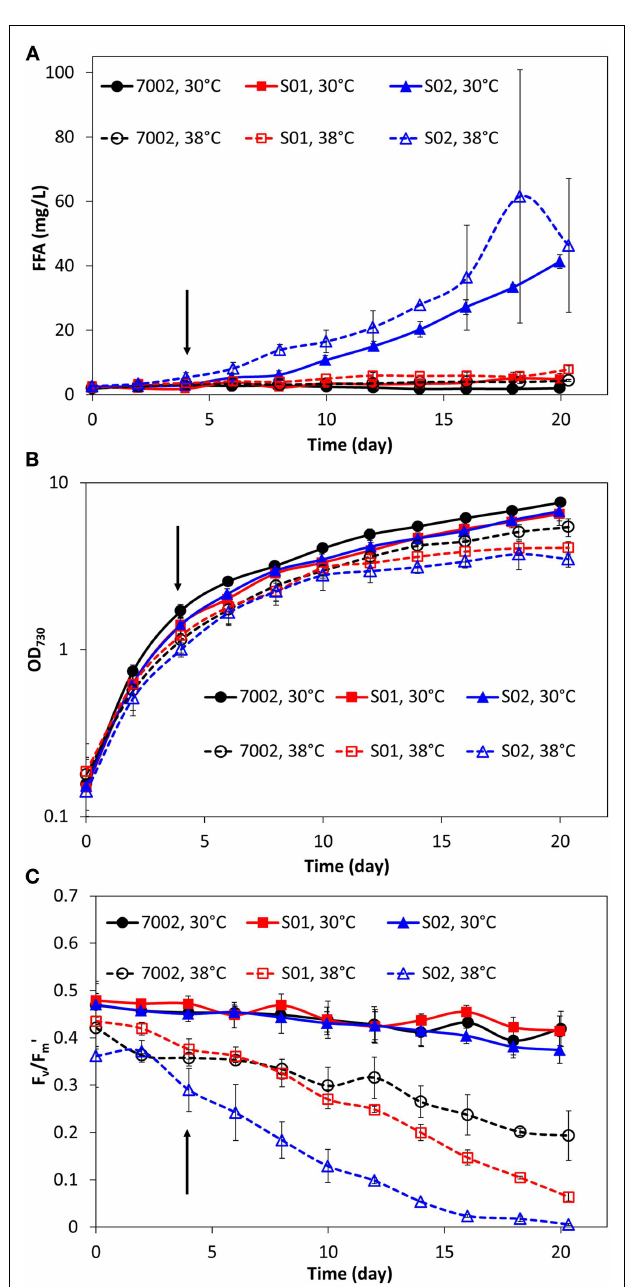
FIGURE 2 | Comparison of extracellular FFA concentration (A), cell concentration (B), and photosynthetic yields (C) during FFA production in Synechococcus sp. PCC 7002 strains at two temperatures: 30°C (solid lines, filled markers) and 38°C (dashed lines, open markers) . Addition of IPTG is indicated by the arrows (100h). All data are averages of at least three biological replicates with error bars indicating the standard deviation.